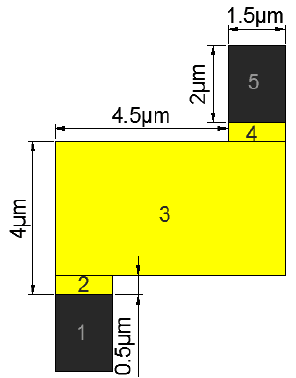
Figure 11. The division of the nanorobot.